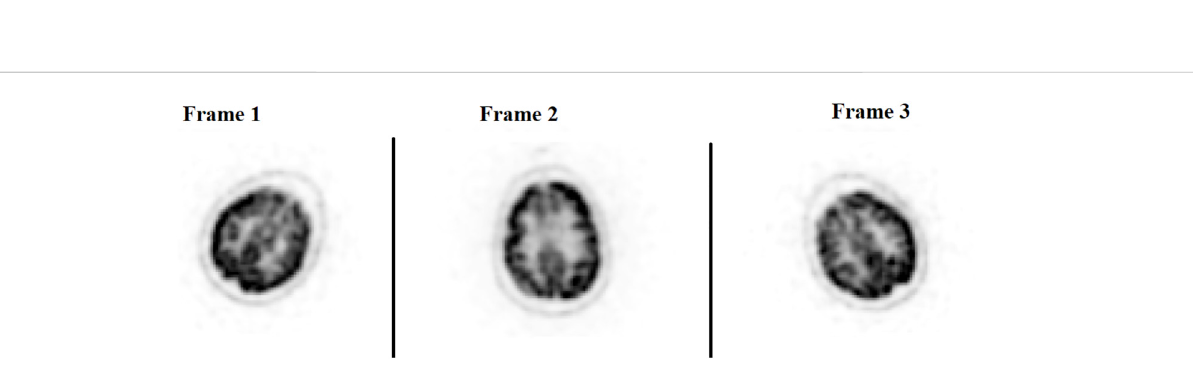
Table 1 compares the neural network performance in individual image registration in terms of mean Dice index and computational time against the ANTs algorithm for the synthesized dataset. The neural network performed close to the conventional iterative